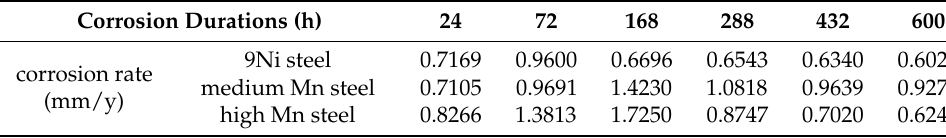
Figure 2. Average annual corrosion rates variation of test steels: ( a ) medium-Mn steel; ( b ) medium-Mn and comparison steels. Table 1. Annual corrosion rates of test steels.